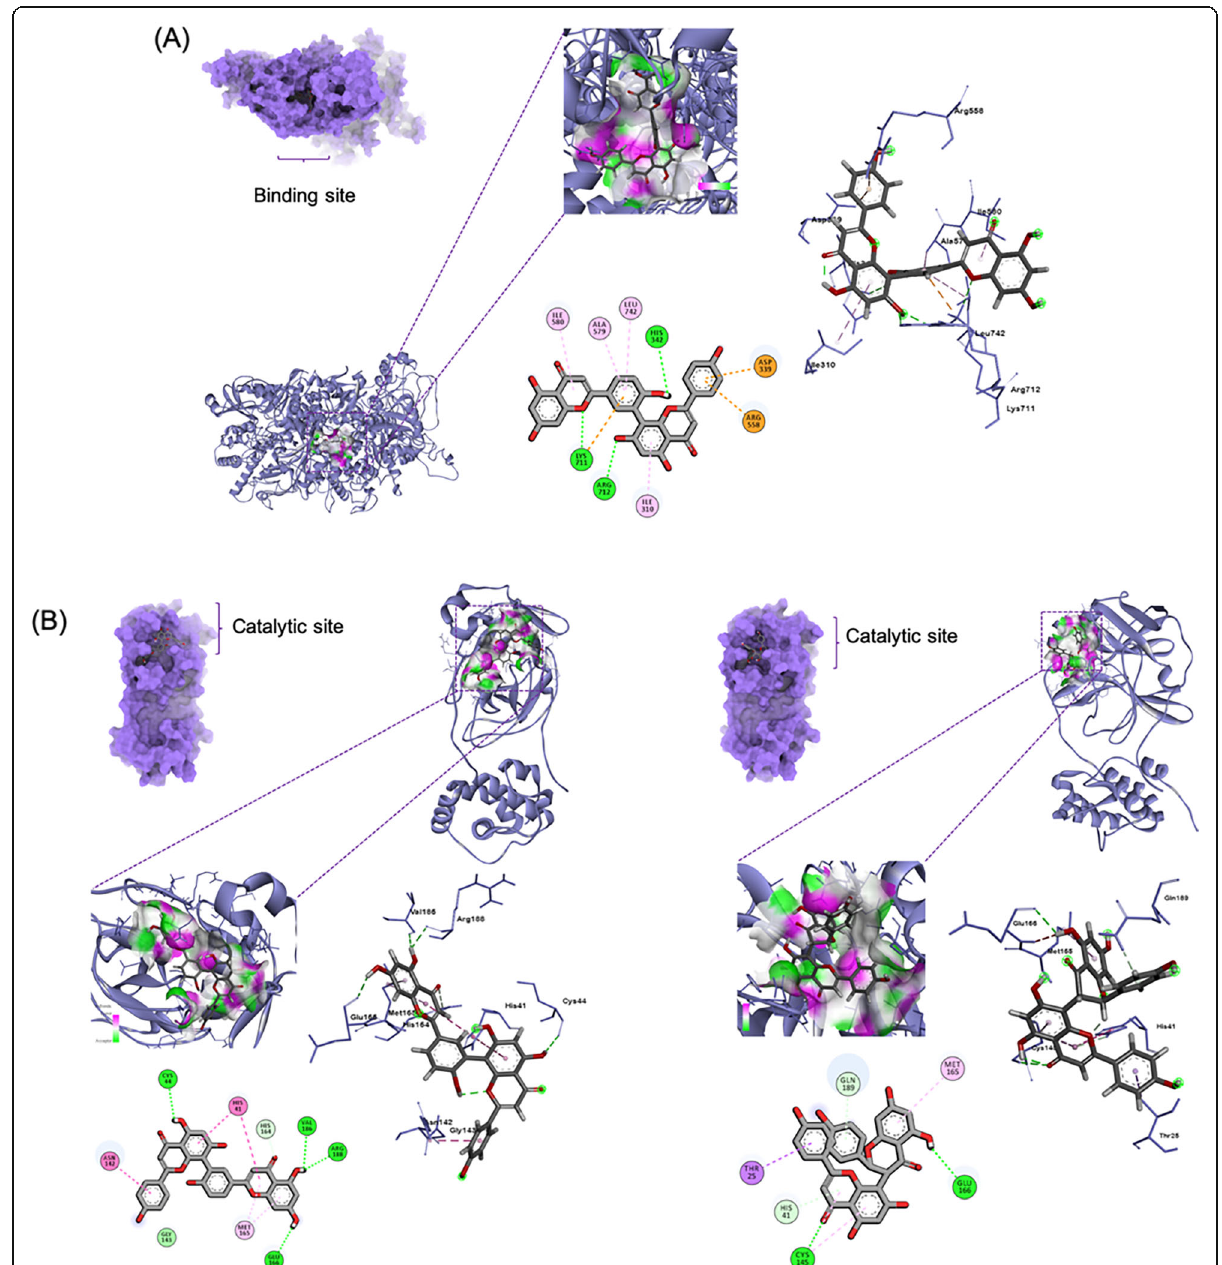
Fig. 2 Top 1-binding compounds in complex with their target cysteine proteases: A amentoflavone ( 1 ) in complex with PLpro, B amentoflavone ( 1 ) (left) and volkensiflavone ( 11 ) (right) in complex with